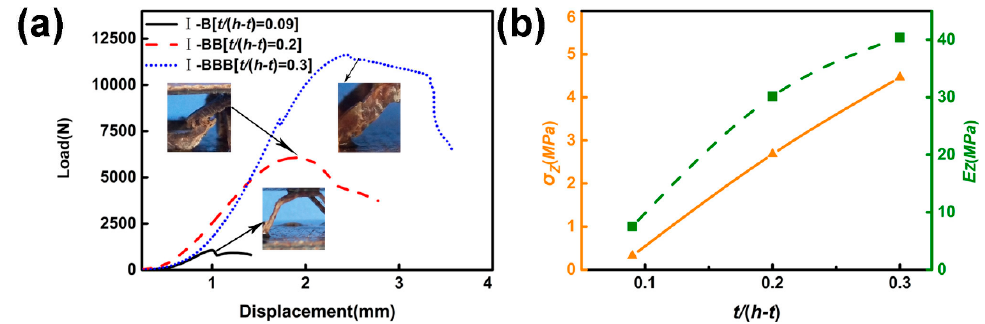
Figure 10. ( a ) Displacement-load curve of I-B, I-BB and I-BBB ( b ) Relationship between compressive strength and t /( h − t ).